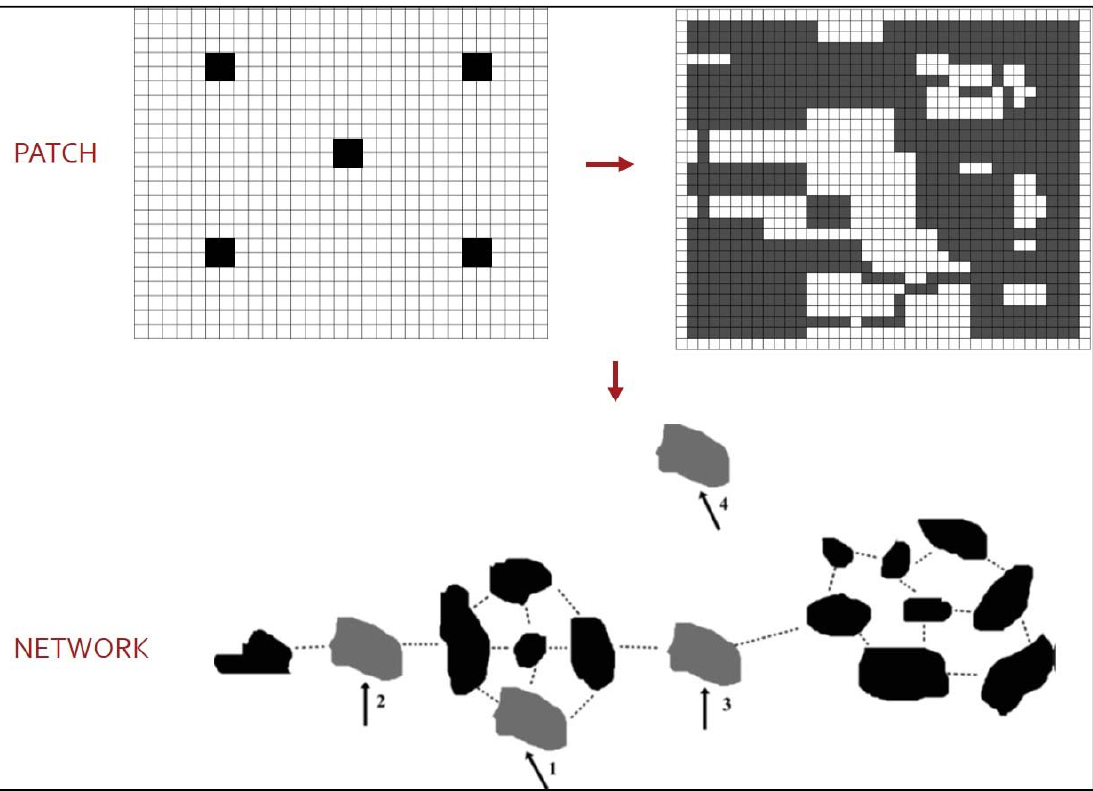
Figure 7. The conceptual diagram from the patch to network in surface UHI studies. The top left black square means the UHI patch (vector), and the top right is the same as the MSPA model (raster). Below is an example to illustrate different UHI patches in terms of their different connectivity roles (graph). Specifically, patch 1 is connected but not a key “stepping stone”, but patches 2 and 3 are key “stepping stones” that need to be blocked or destroyed as a priority. Furthermore, patch 3 is more critical than patch 2 due to a more important connectivity role in a network. Patch 4 is an isolated UHI parch. Therefore, considering the connectivity role of the UHI patches in a network, Patch 3 > Patch 2 > Patch 1 > Patch 4, so these mean that patch 3 needs to be priority considered to block/destroy to mitigate regional heat island effect.